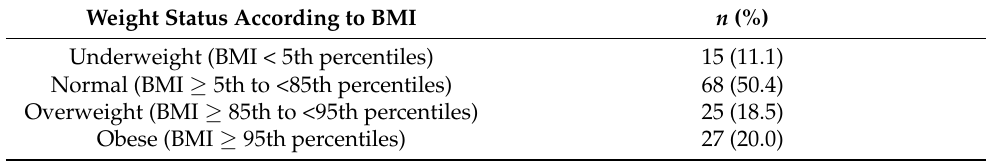
Table 2. Weight status according to body mass index (BMI) for children with ASD ( n = 135). Weight Status According to BMI